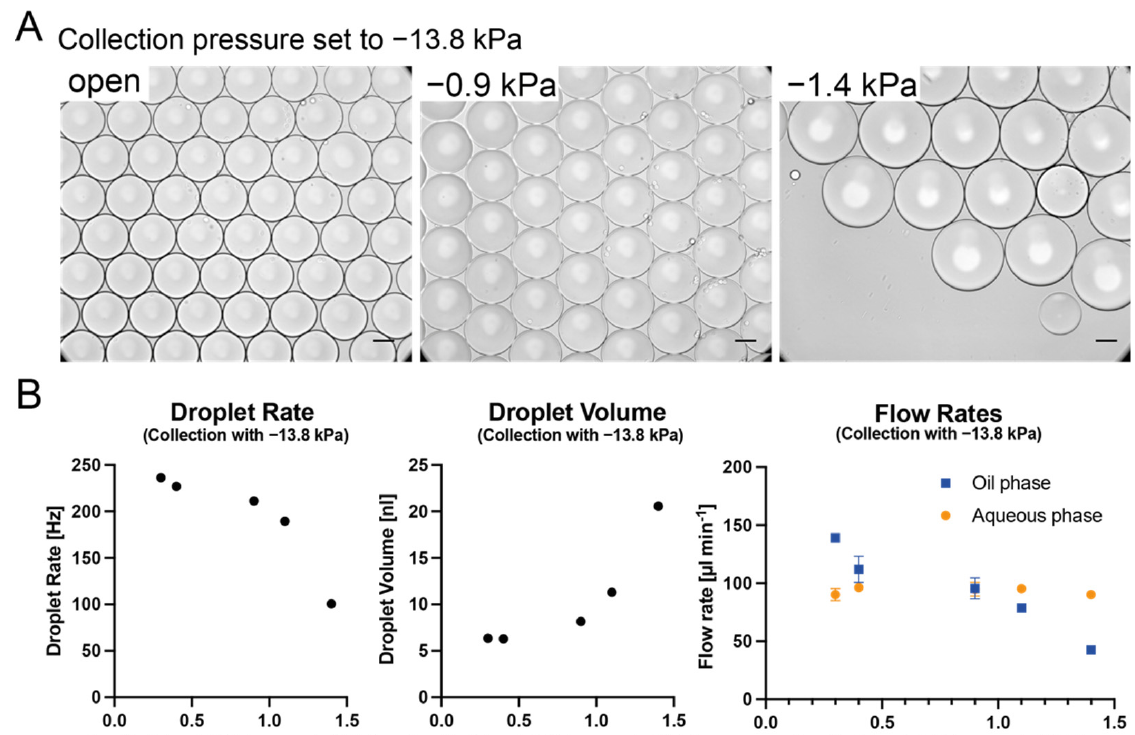
Figure 6. Dual-pump configuration droplet generation. ( A ) shows representative images of the emulsion resulting from − 13.8 kPa applied at the outlet, with varying pressures applied to the oil reservoir. Black scale bar denotes 100 µm. ( B ) shows droplet rate and volume and the flow rates for both phases with different pressures applied at the oil reservoir. An increase in the applied negative pressure at the oil reservoir decreases the droplet rate while increasing the droplet volume. The aqueous flow rate is largely unaffected by this, whereas the oil flow rate decreases.